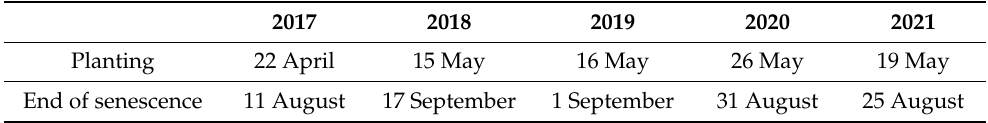
Table 1. Date of planting and emergence of the potato growing